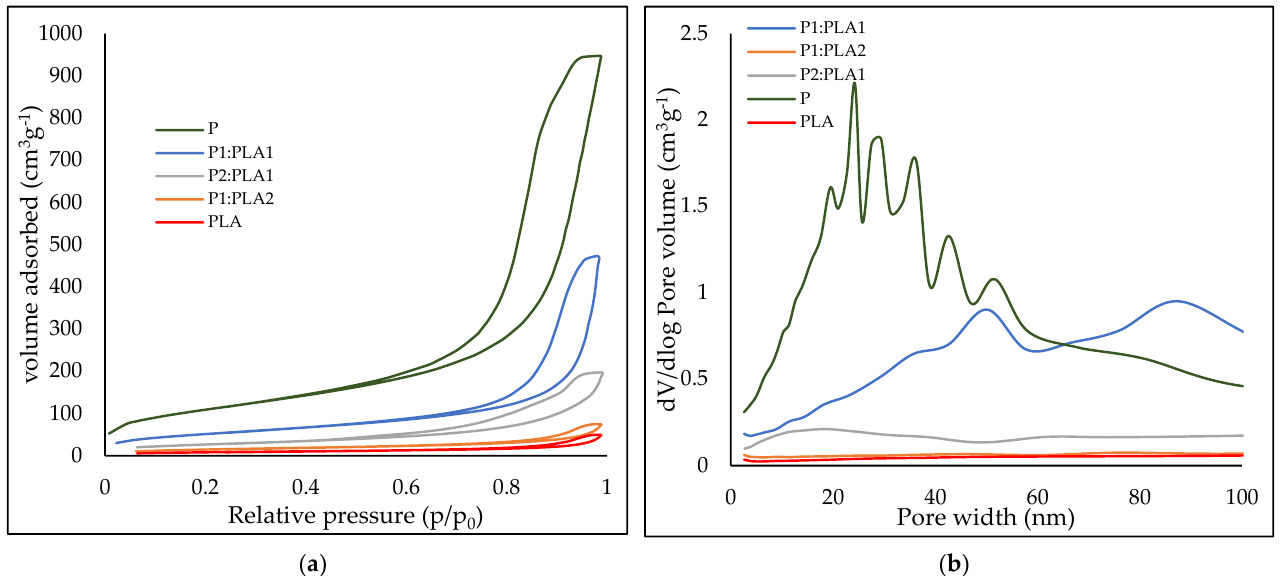
Figure 3. ( a ) Nitrogen physisorption curves and ( b ) Average mesopore size of the reference materials (P and PLA) and hybrids (P1:PLA1, P2:PLA1, and P1:PLA2)